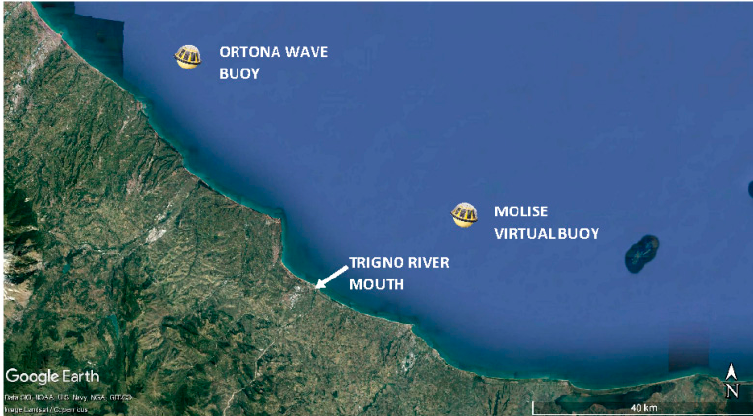
Figure 2. Ortona wave buoy and “virtual” wave buoy at the Molise coast.